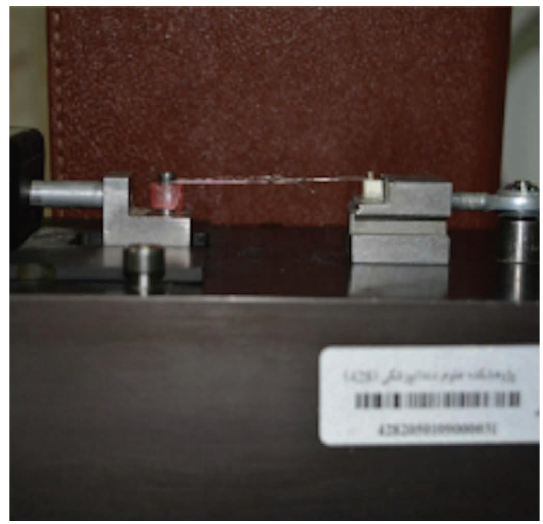
Figure 1: Microshear